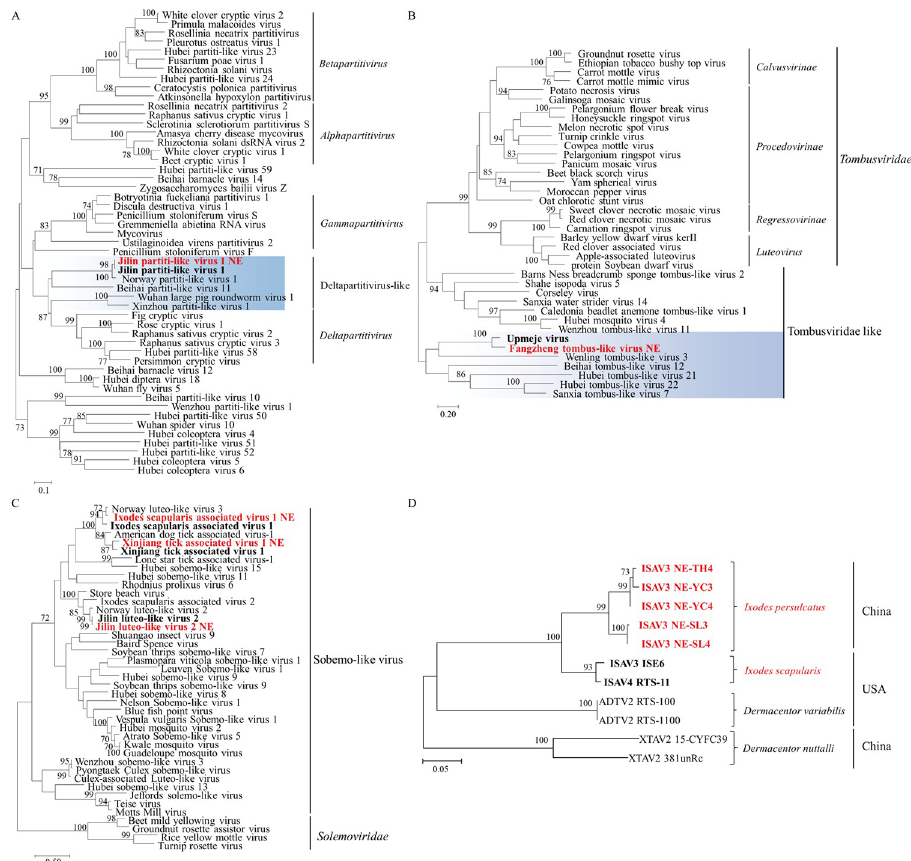
Fig 8. Phylogenetic analyses of plant-related viruses. Phylogenetic trees constructed based on the RdRp protein sequences of representative viruses in the family Partitiviridae (A), Tombusviridae (B), Solemoviridae (C), and ISAV3 (D). All the viruses obtained in ticks here were highlighted in red, and the closest referenced viruses were also highlighted in bold font. Abbreviations: JPLV1, Jilin partiti-like virus 1; NPLV1, Norway partiti-like virus 1; FTLV, Fangzheng tombus-like virus; ISAV3, Ixodes scapularis associated virus 3; ISAV4, Ixodes scapularis associated virus 4; XTAV2, Xinjiang tick associated virus 2; ADTV, American dog tick associated virus 2. The accession numbers of the viral sequences are shown in S2 and S3